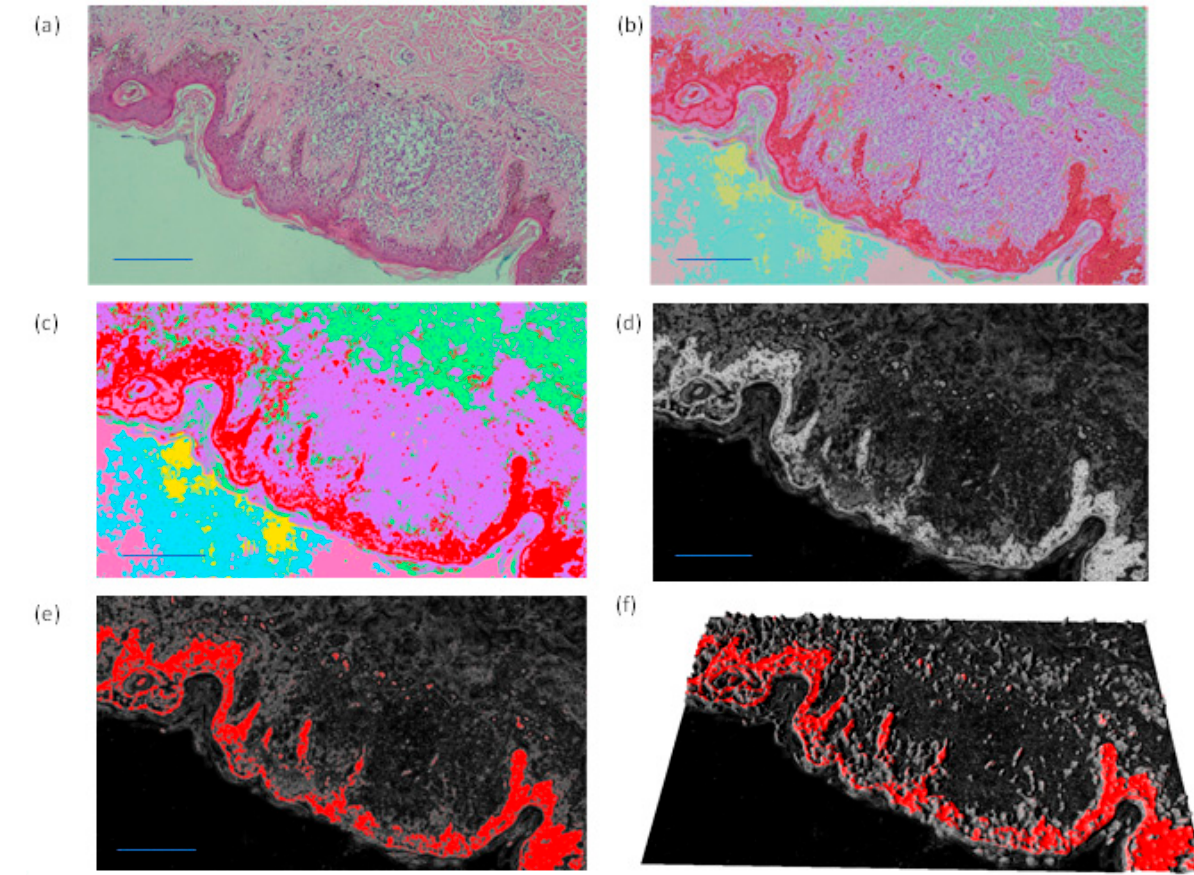
Figure A1. ( a ) Original image. ( b , c ) Images with all detected classes defined by different colors. ( d , e ) Probabilistic image and ( f ) related 3D reconstruction. Figure A1 indicates possible alternative color schemes to highlight dangerous areas: the red color of the classified output image (b, c), the white color of the probabilistic images (d) and the red color of the probabilistic image in a 2D (f) and 3D scheme (g).